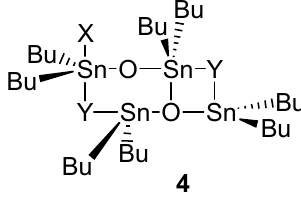
Figure 6. Distannoxane catalysts.